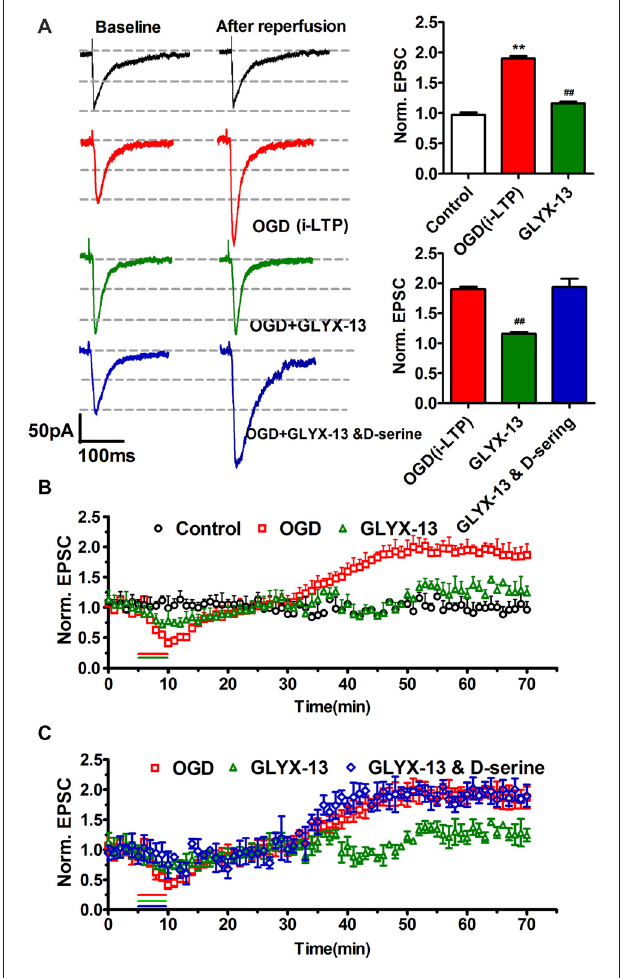
FIGURE 9 | GLYX-13 ameliorated pathological potentiation of excitatory postsynaptic current (EPSC). (A) Sample traces were presented; bar chart of the data showed the effects of GLYX-13 on ischemic long-term potentiation (i-LTP; n = 5, one-way ANOVA and Newman-Keuls post test, ∗∗ p < 0.01, compared with control; ## p < 0.01, compared with oxygen-glucose deprivation (OGD) group). (B) The changes in pathological i-LTP were under various conditions. GLYX-13 at 10 µ mol/L completely abolished i-LTP. As a control, no obvious change in EPSCs was observed when hippocampal slices were not suffered from OGD treatment. (C) Suppression of i-LTP induced by GLYX-13 was reversed by full glycine site agonist D-Serine (100 µ mol/L).